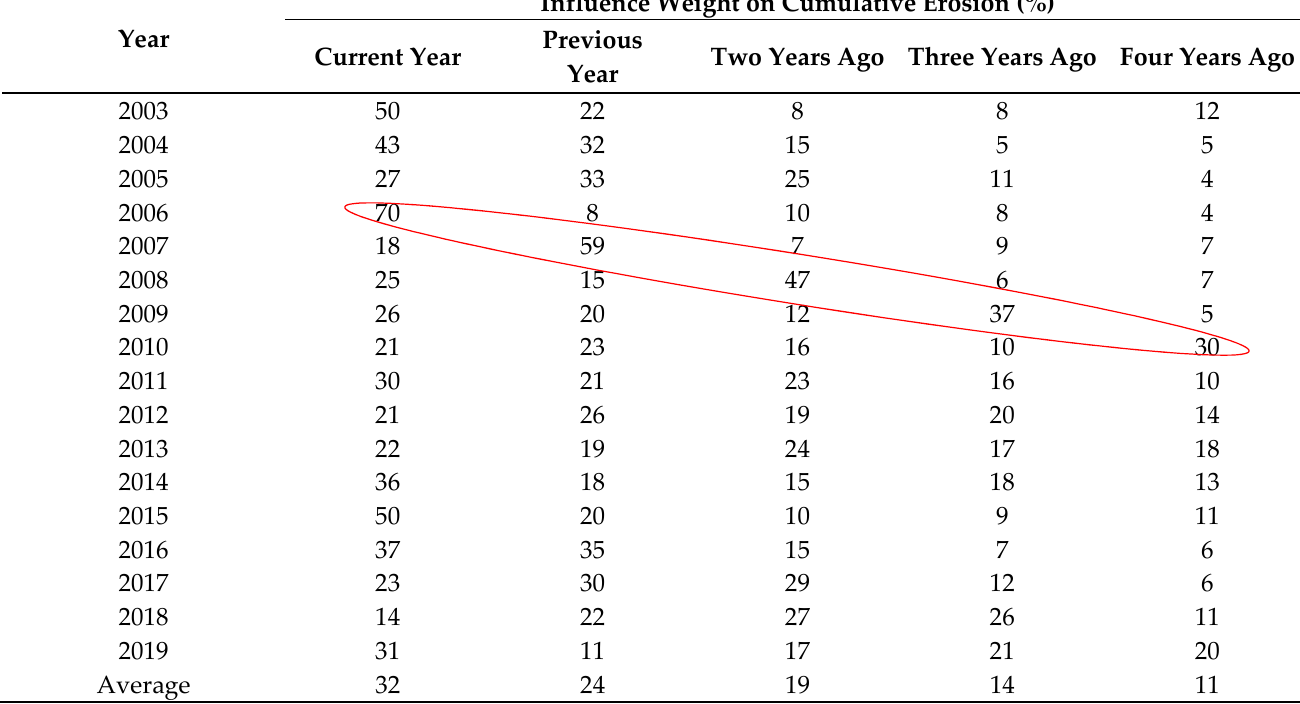
Note: The figures in the red circle represent the influence weights of the incoming flow and sediment regimes in 2006 for each year from 2006 to